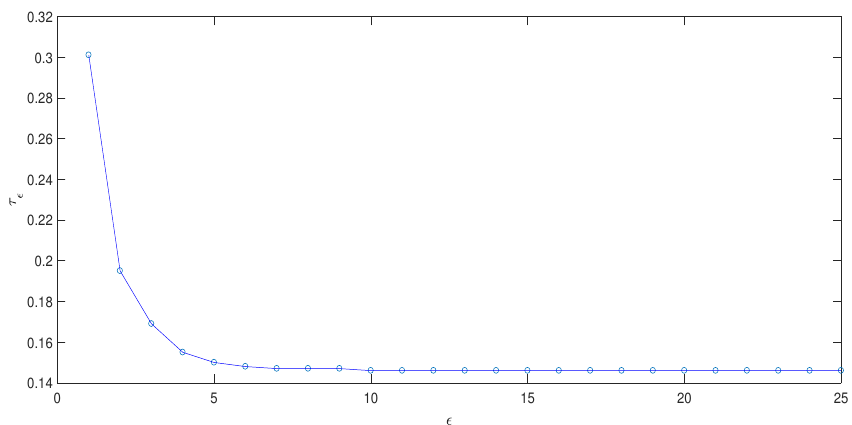
Figure 3. The orbit of τ σ vs. σ